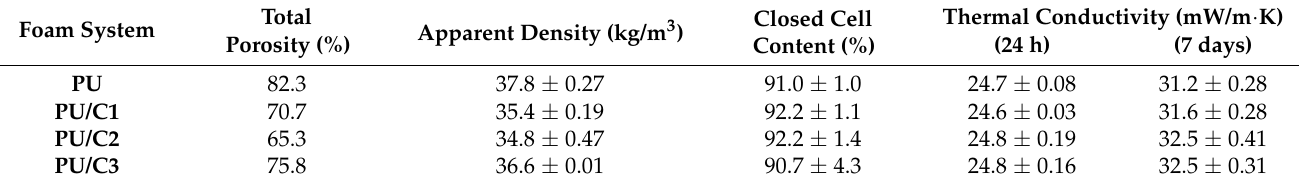
Table 5. Total porosity, apparent density, and thermal conductivity of RPURFs.